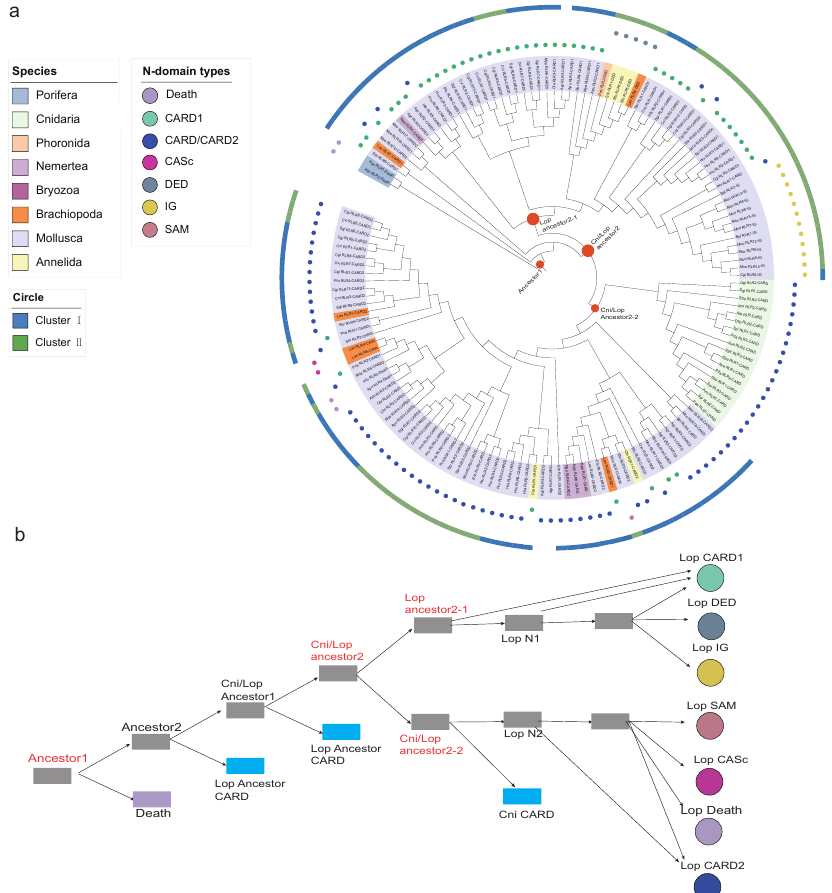
Figure 5. The evolution of N-terminal domains (CARD, DED, IG, death, CASc, SAM) of lophotro- chozoan RLRs . ( a ) Phylogenetic tree constructed with the maximum likelihood method showing the evolution of N-terminal domains of RLRs in lophotrochozoans. The different background colors of the gene names represent the phyla to which they belong, as shown in the legend ‘Species’. The different colored circles represent different domains, as shown in the legend ‘Domain’. The blue arc in the outermost circle represents Cluster I, and the green arc represents Cluster II. The orange circles on the branches marked on the tree correspond to the important nodes in ( b ). ( b ) A schematic diagram of the evolution of the N-terminal domains of RLRs in lophotrochozoans based on the phylogenetic tree. Cni stands for Cnidaria, and Lop stands for the lophotrochozoan. Ancestor1 indicates an ancestor where a duplication produced the first N-terminal death domain and a common ancestor of all other N-terminal domains. Cni/Lop ancestor2 indicates an ancestor where a duplication occurred that produced different N-terminal domains. Lop N1 represents the first domain of the N-terminal RLR, and Lop N2 represents the second. Solid black lines indicate duplication events. Colors of N-terminal domains correspond to color labels in the trees in ( a